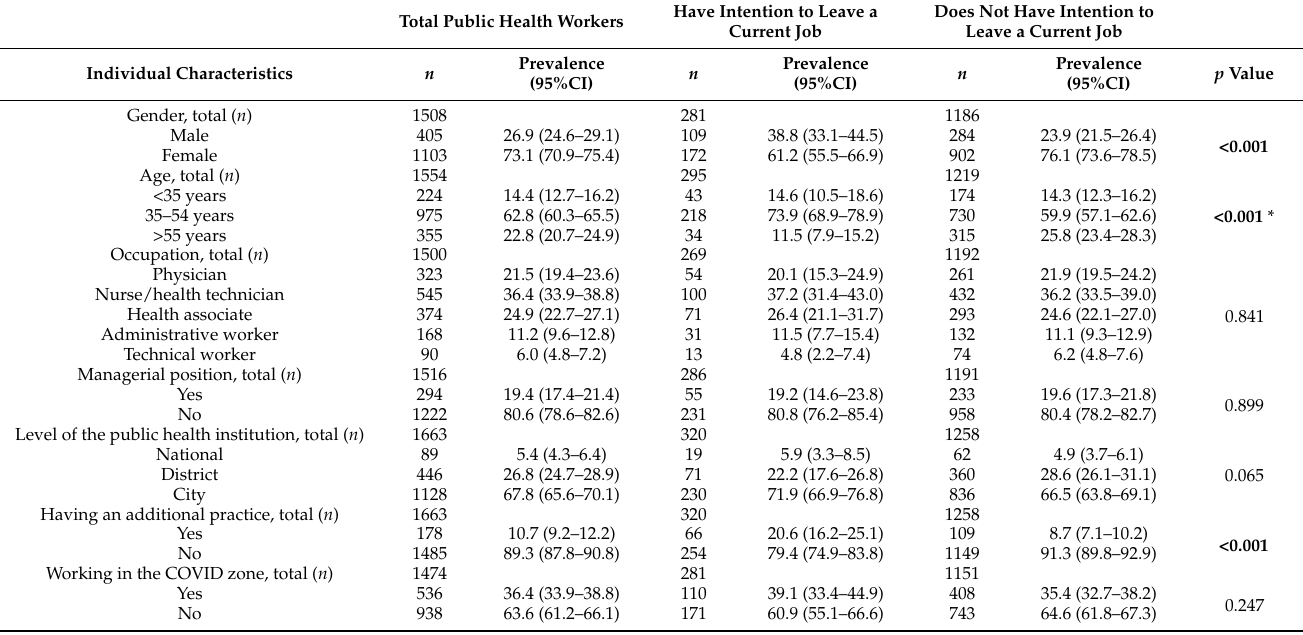
Table 1. Individual characteristics of public health workers from 25 public health institutes ( n = 1663), according to their intention to leave a current job within the next five years, Serbia, 2020.